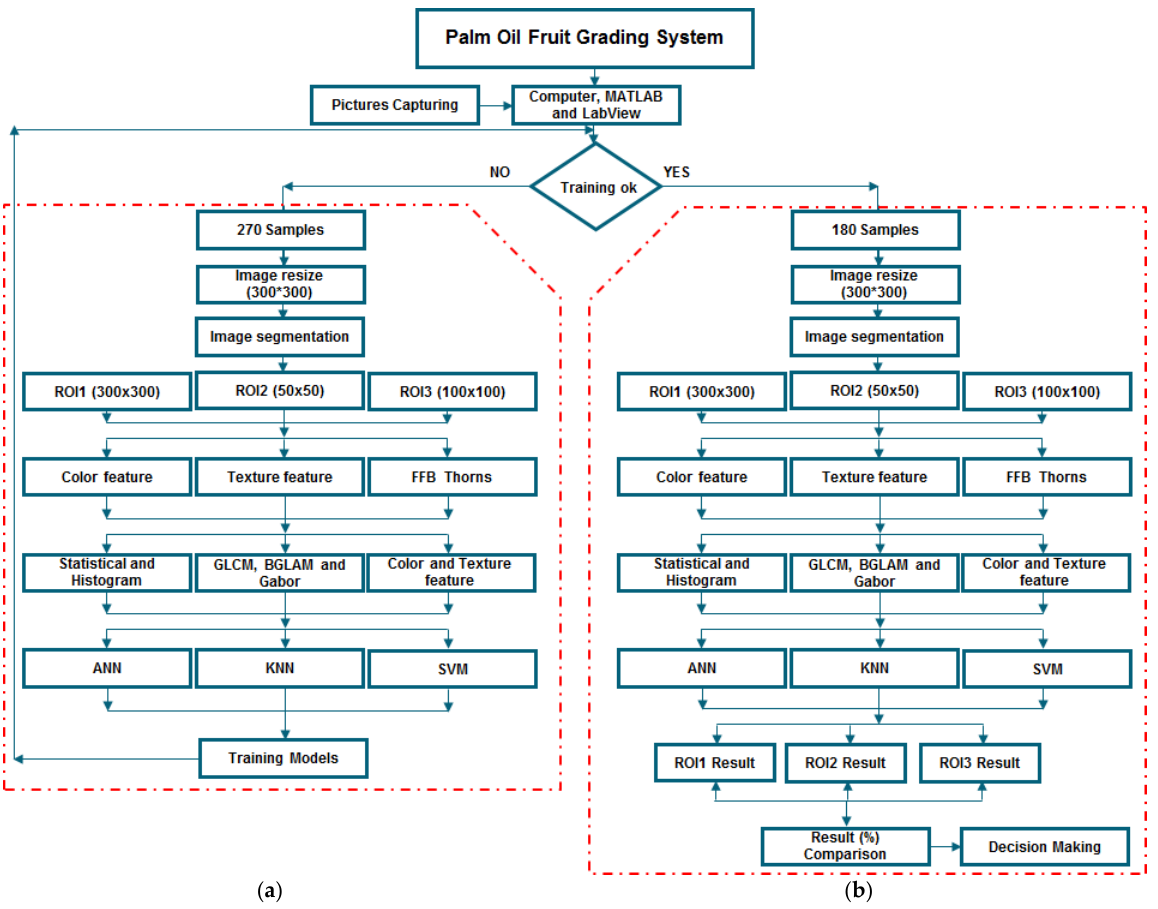
Figure 10. Training and testing stages of the oil palm ripeness grading system: ( a ) training stage and ( b ) testing stage.